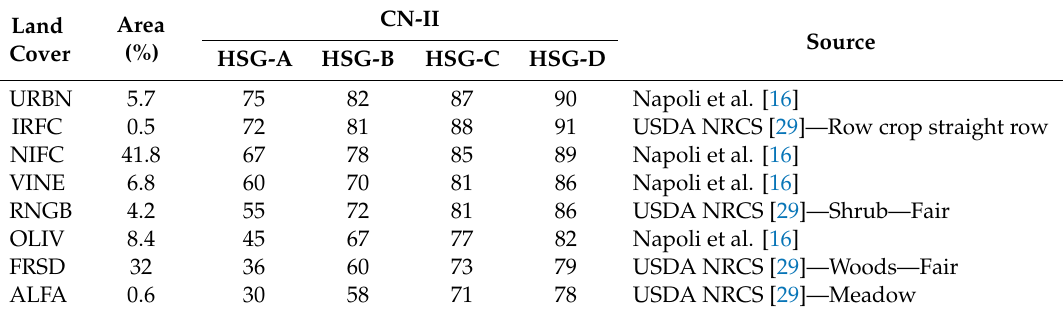
Table 2. Curve Number values for (CN(AMC-II)) for each land covers and categories from A to D. The land cover classes were as follows: meadow (ALFA); broad-leaved forest (FRSD); irrigated field crops (IRFC); unirrigated field crops (NIFC); olive groves (OLIV); transitional woodland-shrub-brush (RNGB); artificial surfaces (URBN); vineyards